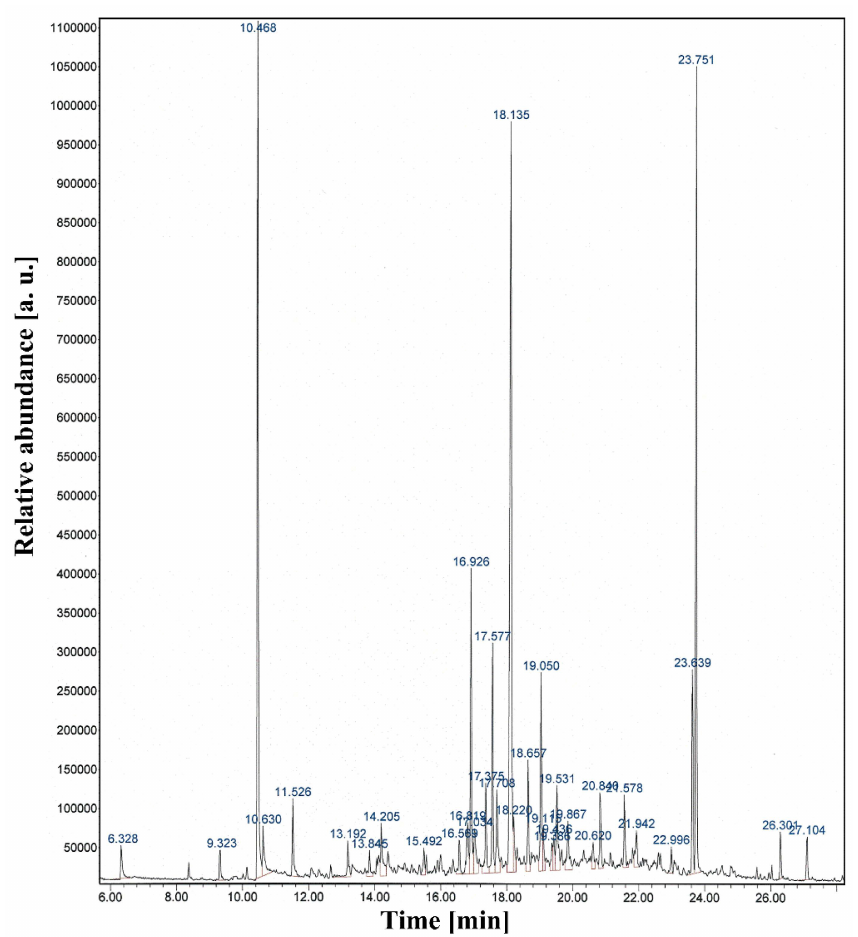
Figure 7. Total ion count chromatogram of pPANI NwN thin film obtained using